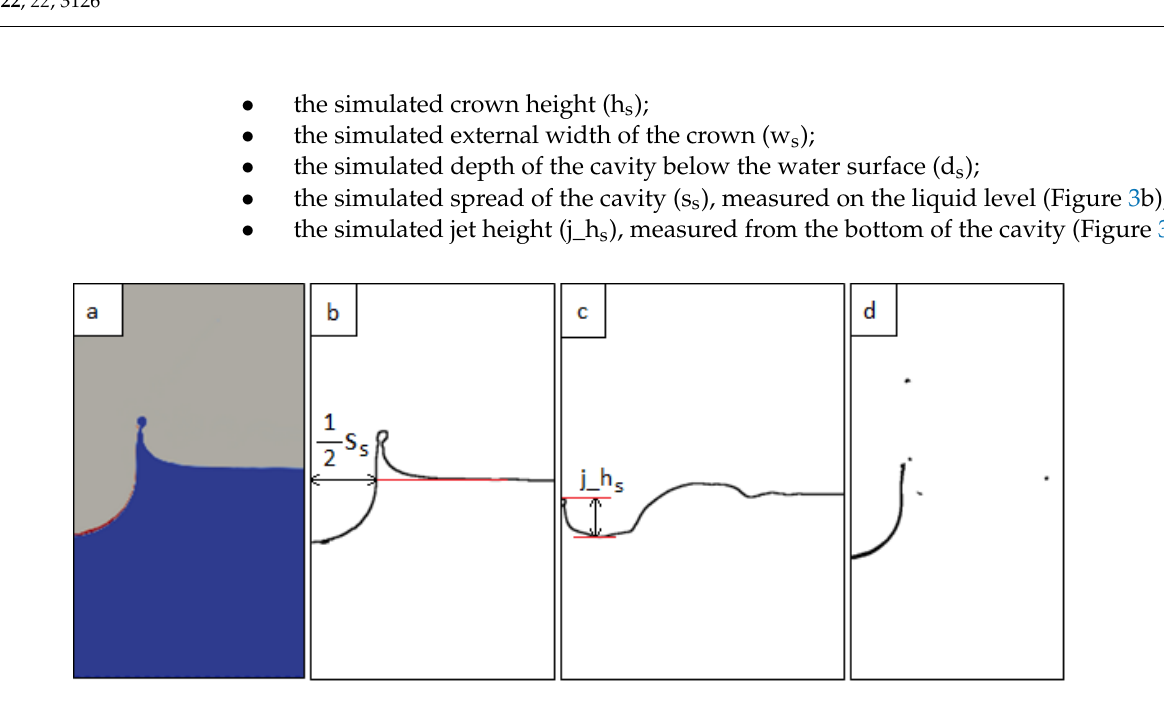
Figure 3. Example of a splash simulation scan from ParaView ( a ): blue —water, red—petrol, grey— air; ( b ) simulated primary splash forms: crown and cavity; ( c ) simulated secondary form: jet; ( d ) simulated distribution and dispersal of petroleum substance.